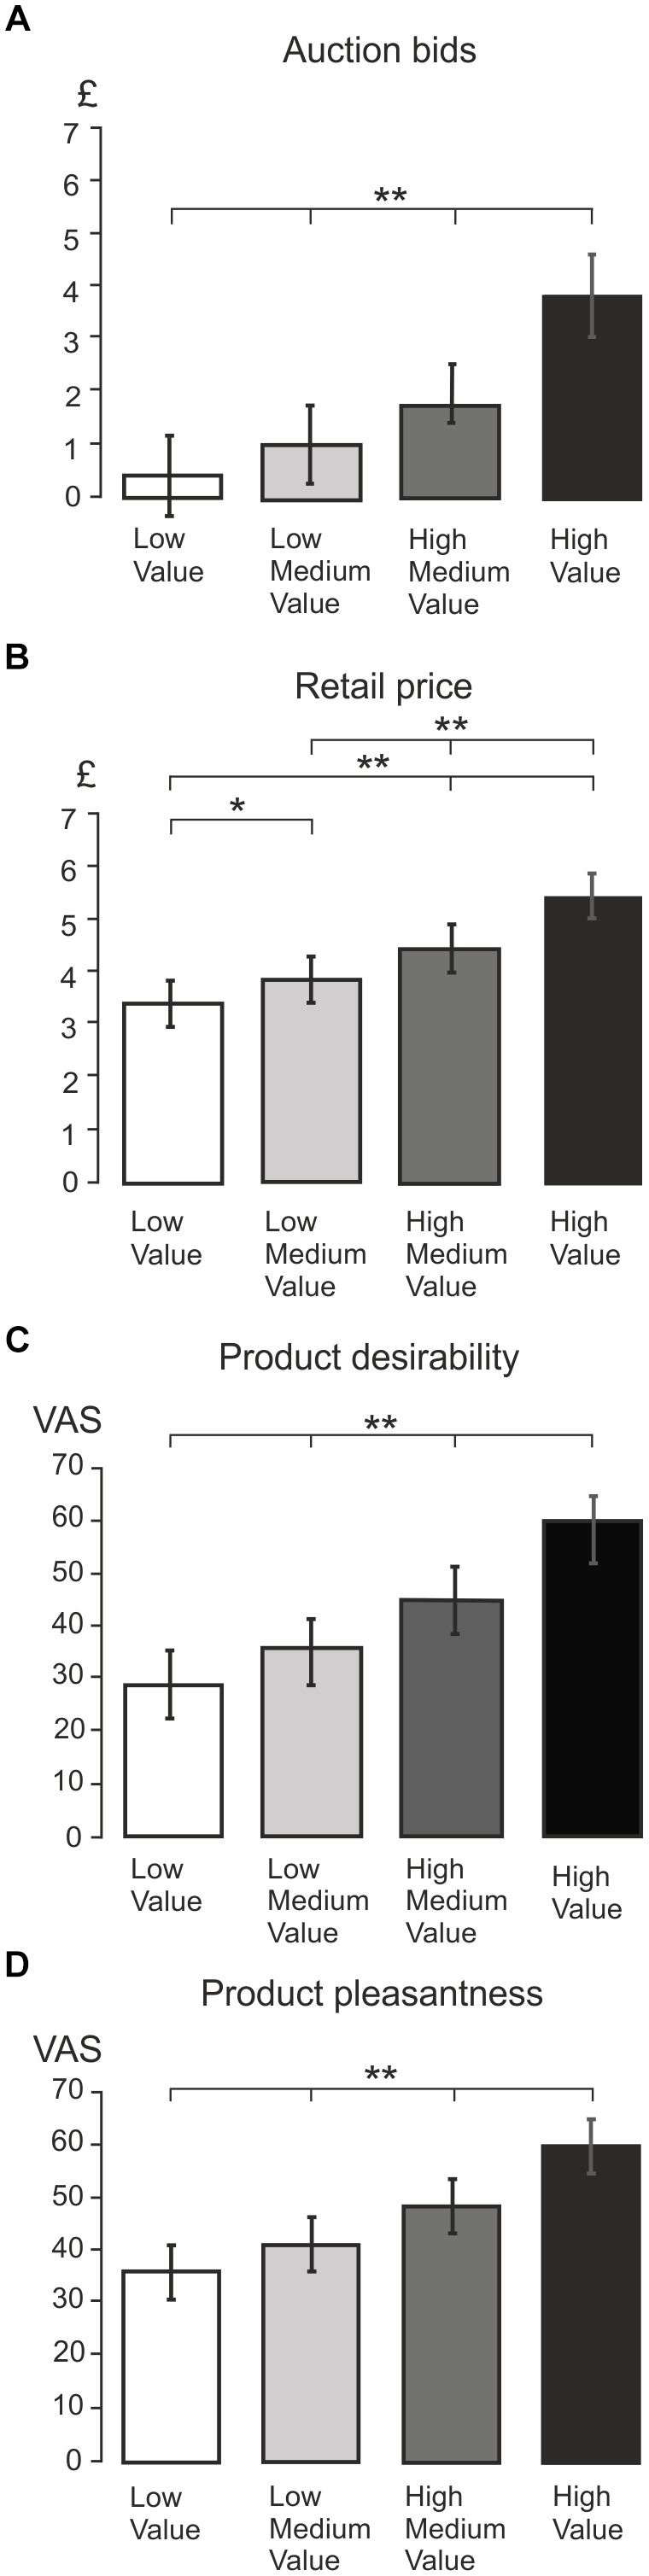
Average behavioral ratings. (A) Bar graph showing the mean BDM auction bids for four different value levels: low, low medium, high medium, and high value. The value conditions are split by subject’s auction rating, and the bar graph shows significant differences between all value conditions. A double asterisk (∗∗) indicates presence of high statistical significance (p < 0.001), and a single asterisk indicates statistical significance (p < 0.05). This provides validation for the splitting product stimuli into four value categories based on BDM auction value. (B) Bar graph showing mean retail price across the four BDM auction value conditions. Highly significant differences were indicated with a double asterisk, and p < 0.05 was indicated with a single asterisk. The bar graph indicates that significant differences were found in retail price across all value levels (p < 0.05), suggesting that BDM auction value ratings mirror the actual retail price of the product. (C) Bar graph showing mean product desirability rating across four value conditions. From the graph it can be seen that mean desirability increased incrementally with BDM value (all p < 0.001). (D) Bar graph showing mean product pleasantness rating across all value levels. Again, this graph shows that mean pleasantness increases incrementally with BDM value (all p < 0.001).